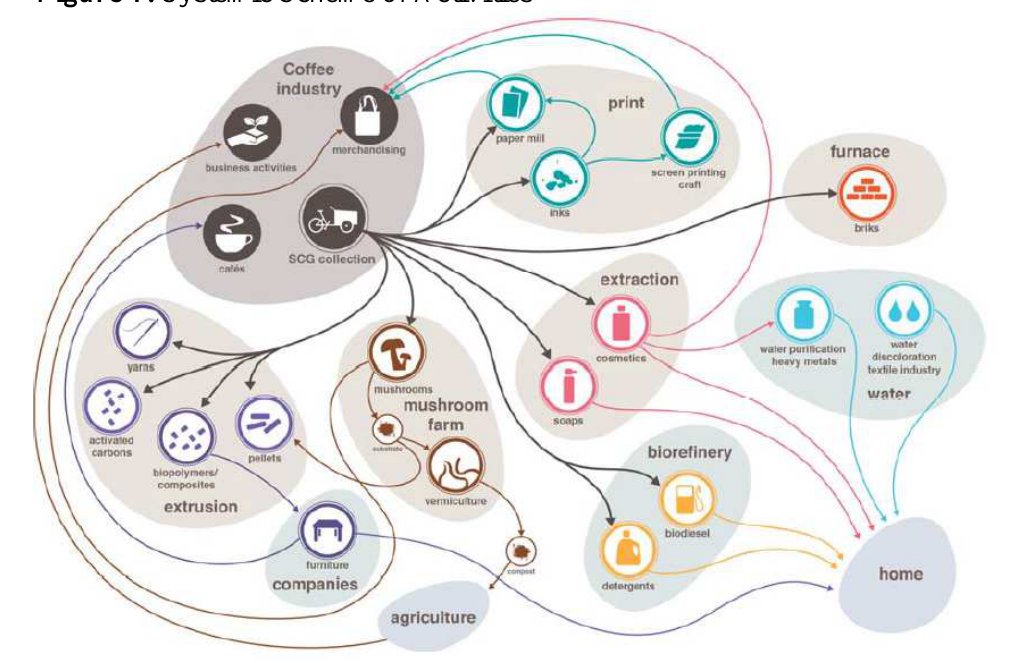
Figure 1: Systemic Scheme of